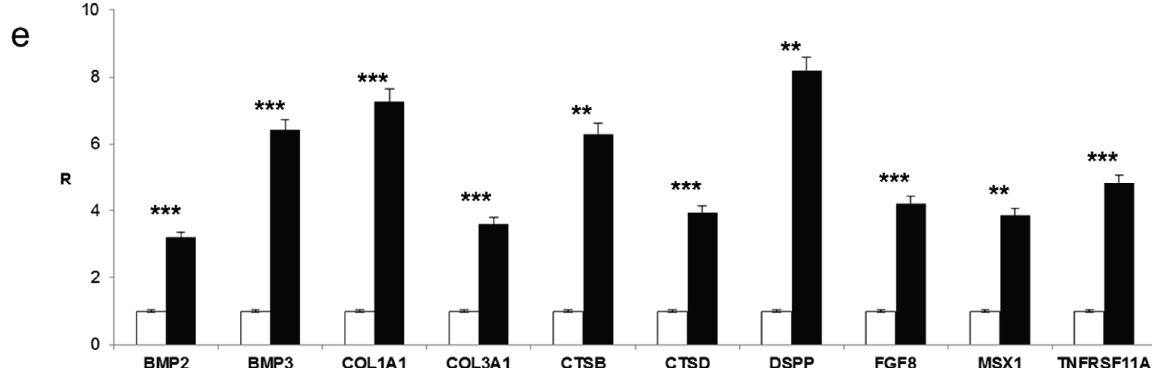
Figure 4. Histological analyses of hyaluronan-DPSCs bone graft one month after rat calvarial defect repair. ( a ) Azan Mallory staining of collagen matrix (yellow arrow), blood vessels (red arrow) and hyaluronan fibers (white circles); ( b ) Masson’s trichrome staining of collagen matrix (yellow arrow), blood vessels (red arrow) and hyaluronan fibers (purple circles); ( c ) Azan Mallory and ( d ) Masson trichrome staining of hyaluronan bone graft without cells; and ( e ) Gene expression profile of dentin ECM-related markers (dentin sialophosphoprotein (DSPP), bone morphogenetic protein 2 (BMP2), BMP3), bone ECM-related markers (COL1A1, COL3A1, cathepsin B (CTSB), cathepsin D (CTSD)) and other bone markers (fibroblast growth factor 8 (FGF8), msh homeobox 1 (MSX1), tumor necrosis factor receptor superfamily (TNFRSF11A)) in the hyaluronan-DPSC bone graft (black bars) compared to the hyaluronan scaffold alone (white bars). Significant differences between hyaluronan-DPSCs bone graft and hyaluronan scaffold alone ( ** p < 0.01; *** p < 0.001); R: relative